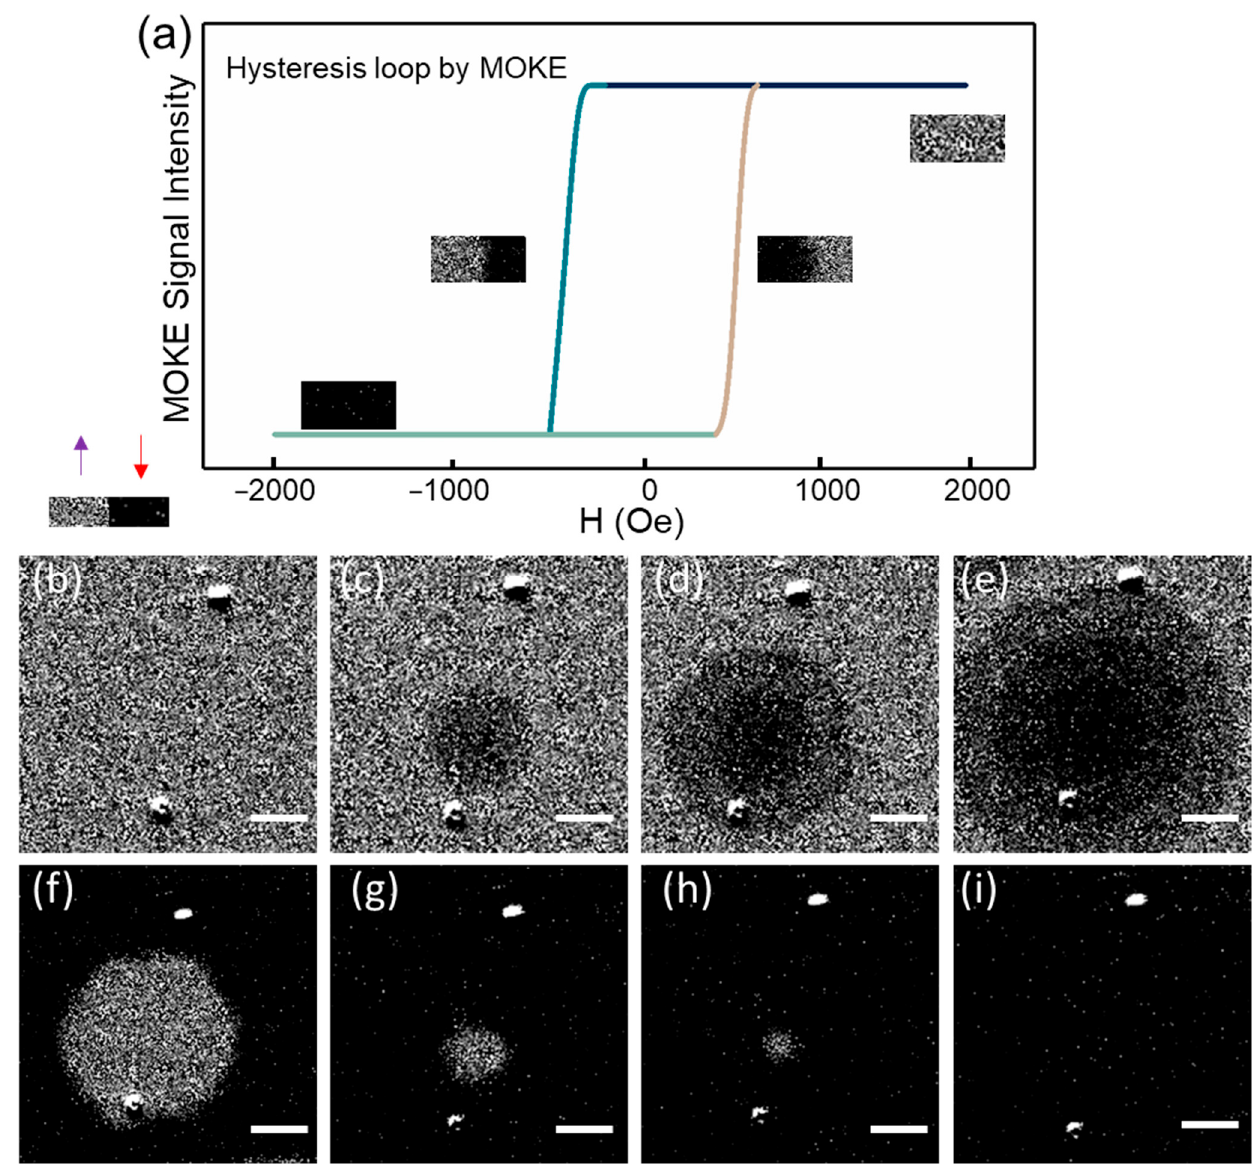
Figure 5. ( a ) Hysteresis loops measured by MOKE microscope. The inset shows the domains with up (white) and down (dark) magnetizations. ( b – i ) Image of the evolution of the magnetic domain as a function of applied field obtained after background subtraction by magneto-optic Kerr microscope. The scale bar is 5 μ m.